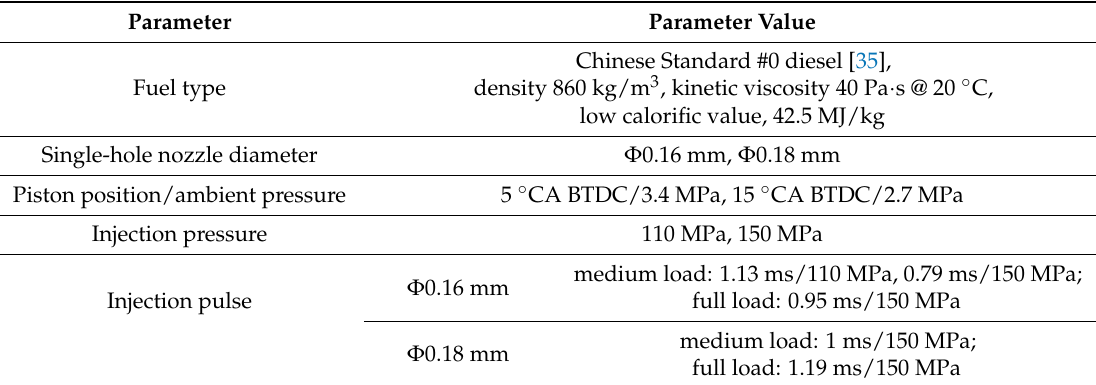
Table 3. Injection conditions and configurations for visualization testing.